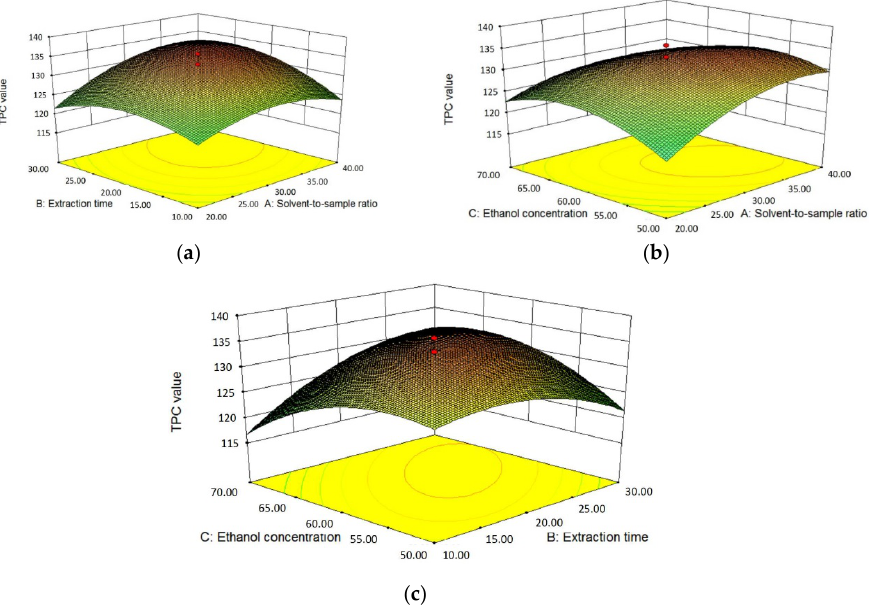
Figure 4. The three-dimensional response surface plots for the effects of solvent-to-sample ratio/extraction time ( a ); solvent-to-sample ratio/ethanol concentration ( b ); and ethanol concentration/extraction time ( c ) on the TPC values.